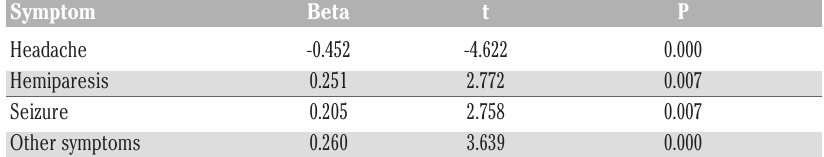
Table 1. Linear regression test of D-dimer serum level in patients with and without cere- bral venous